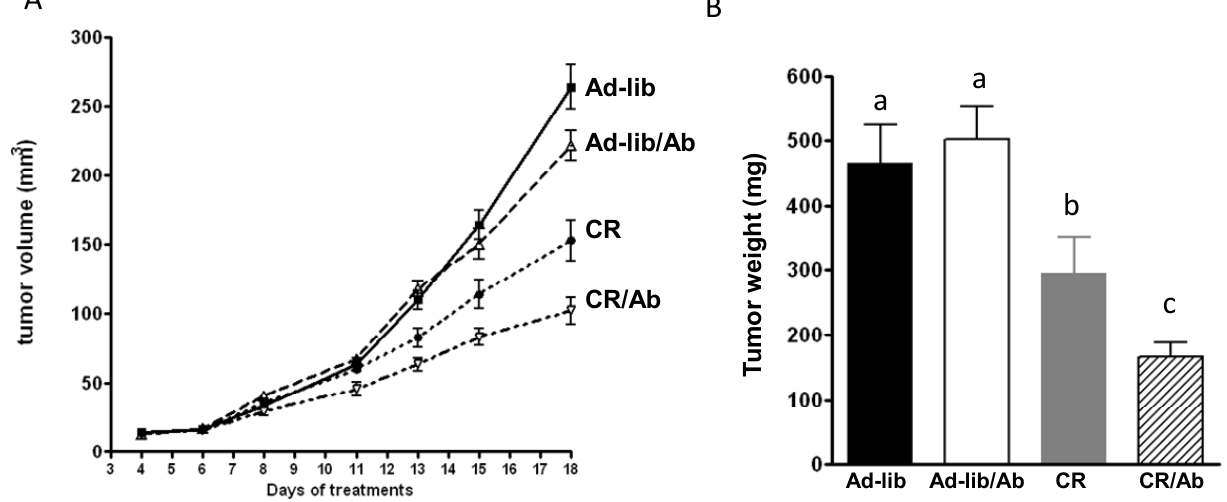
Figure 2. Tumor volumes and weights. ( A ) Tumor volumes: once the tumors became palpable, tumor volume was measured twice weekly. Values are expressed as mean ± SEM; and ( B ) Tumor weights. Values are expressed as mean standard errors (SE). Means with different letters are significantly different from each other (one way analysis of